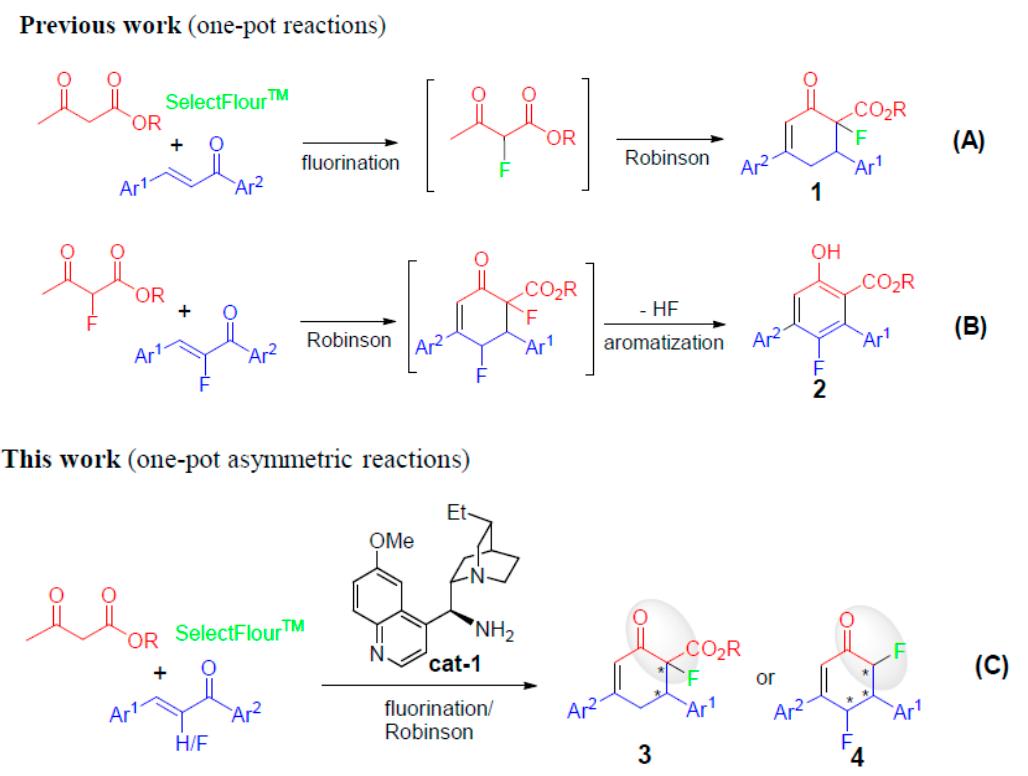
Scheme 1. Robinson annulation-based one-pot